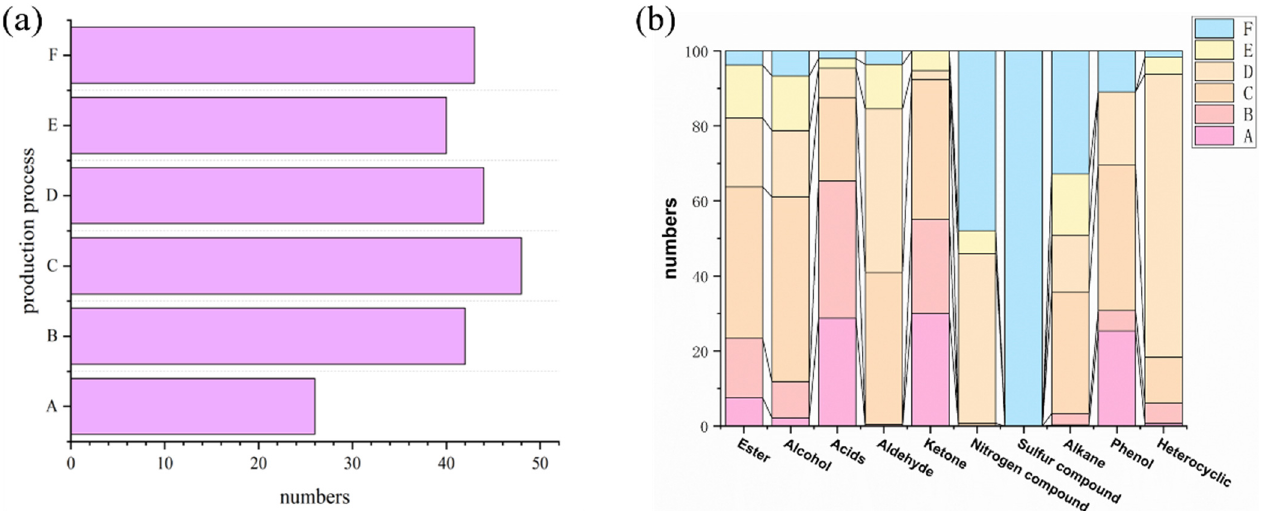
Figure 1. Variation in volatile compounds in dissimilar production process stages of strong-flavor daqu. ( a ) Changes in the total amount of volatile compounds when producing strong-flavor daqu. ( b ) Changes in the types and quantities of volatile compounds in dissimilar production processes of strong-flavor daqu. A, B, C, D, E, and F represent samples from different periods, respectively.